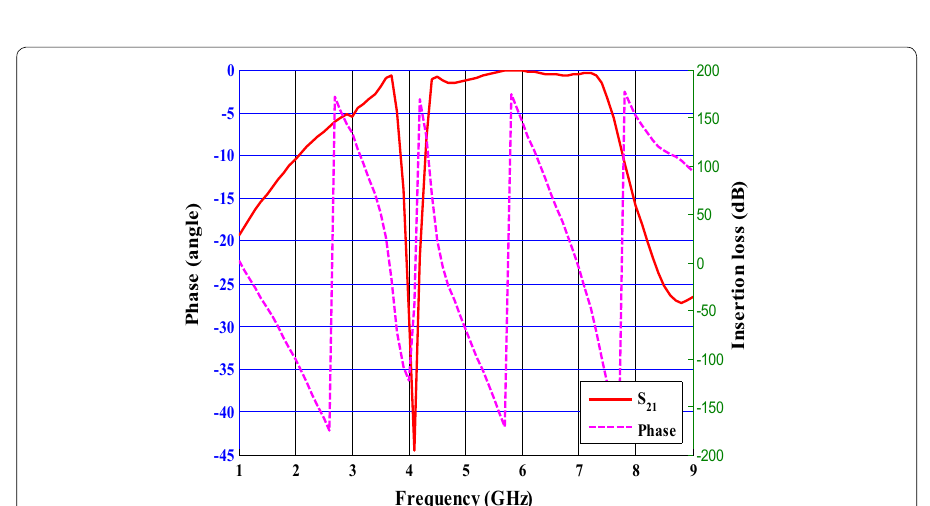
Fig. 4 Simulated S 11 and S 21 of DB-BPF